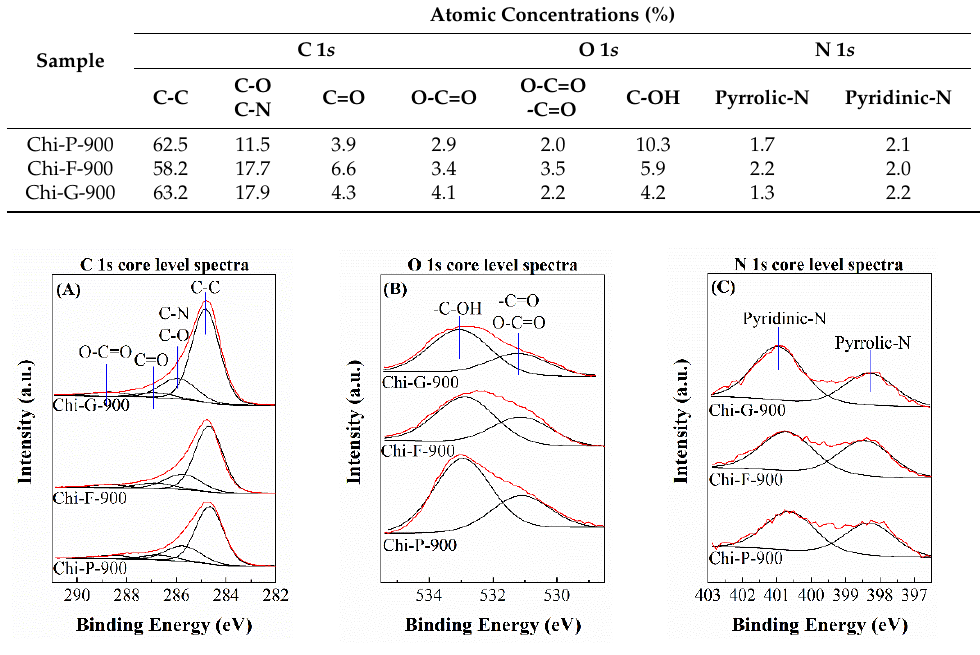
Figure 8. C 1s ( A ), O 1s ( B ) and N 1s ( C ) core level spectra of the biochars obtained after the pyrolytic treatment of chitosans with different textural properties at 900 °C.